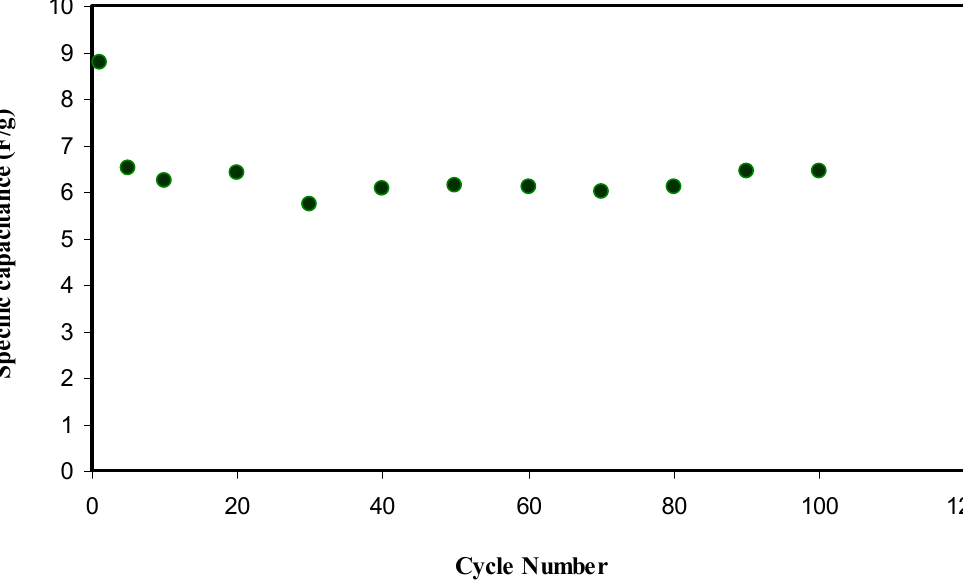
Figure 12. Specific capacitance of the fabricated EDLC for 100 cycles.